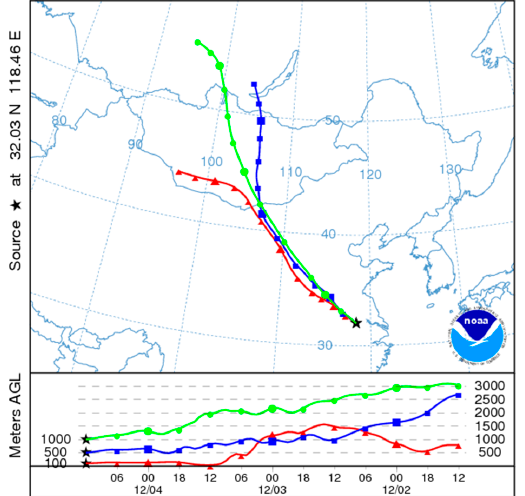
Figure 11. Analysis of the back trajectories of air flows for the 72 h cycle in the winter of 2014 based on the meteorological data of Global Data Assimilation System (GDAS).